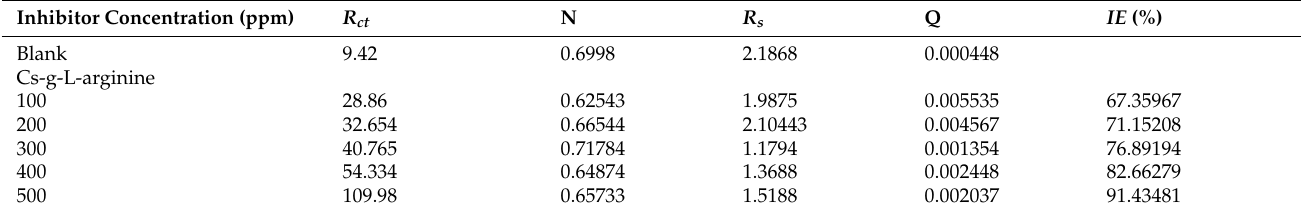
Figure 6. Equivalent circuit used to fit experimental data. Table 2. Electrochemical impedance spectroscopy